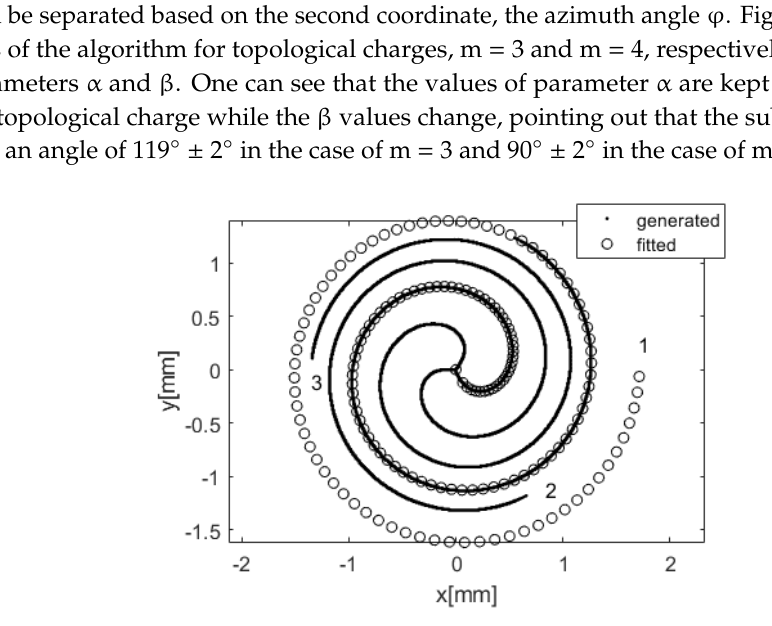
Figure 5. Results of fitting Fermat’s spirals to the LG beam with topological charge m = 3. Parameters of subsequent spirals are (95% confidence bounds) . ( 1 ) Spiral 1, α = 4 .666 (4.659, 4.672) (1/mm 2 ) and β = −1.172 (−1.179, −1.164) ; ( 2 ) Spiral 2, α = 4.589 (4.583, 4.595) (1/mm 2 ) and β = 3.083 (3.076, 3.09); ( 3 ) Spiral 3, α = 4.653 (4.647, 4.659) (1/mm 2 ) and β = 0.944 (0.937, 0.951) .